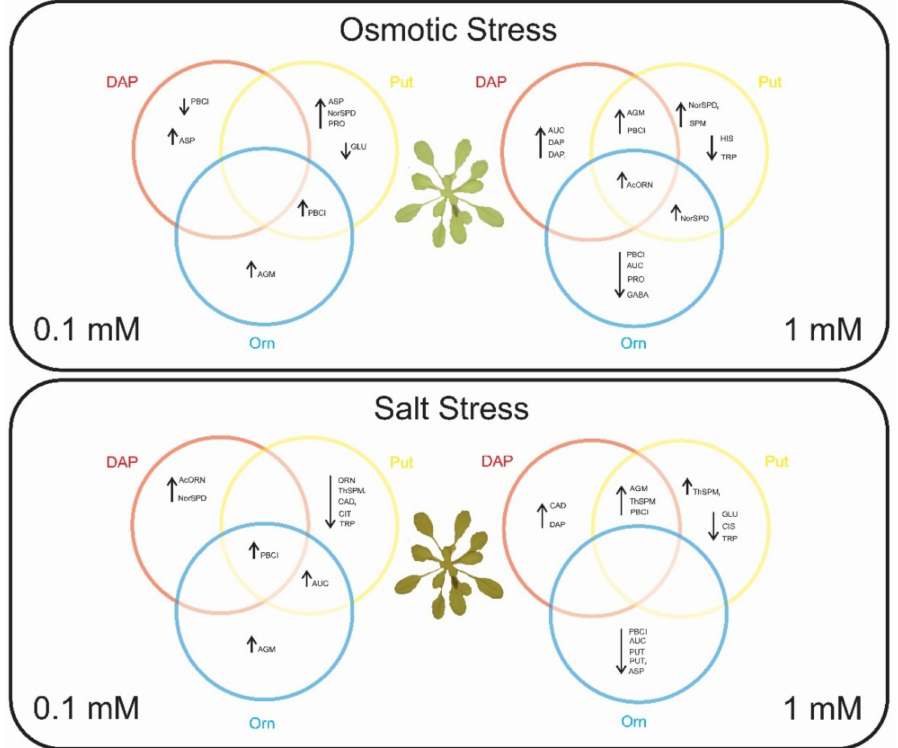
Figure 7. Summary of the reported effects of the seed primings with DAP, Orn, and Put at 0.1 and 1 mM on the Arabidopsis thaliana seedlings exposed to optimal growing conditions, osmotic, and salt stress. Red circles are for DAP, blue circles are for Orn, and yellow circles are for Put; on the left side of the plant is represented the lower concentration priming, while on the right is represented the higher priming concentration. Inside the circles, significant changes regarding growth (AUC), the potential biostimulant effect (PBCI), free and total polyamines, and free amino acids are represented. An upside arrow indicates significant increment, while a downside arrow means significant reduction compared to the unprimed treatment within the same growing condition. Significant factors situated in the intersection of two or all primings mean that that parameter’s change was common for the involved